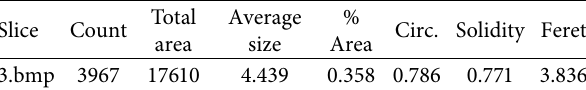
Table 5: Analyzed values at 770 °